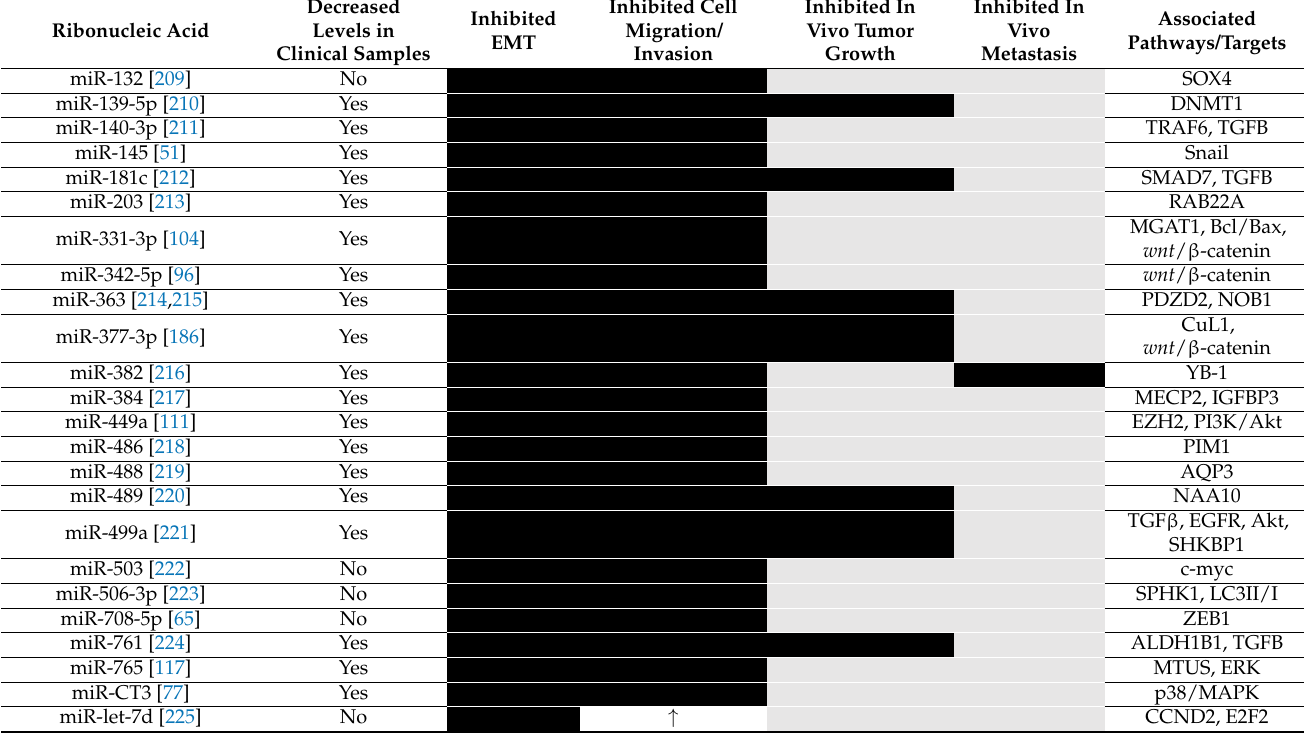
Table 2. Effects of poorly expressed proteins in OS.